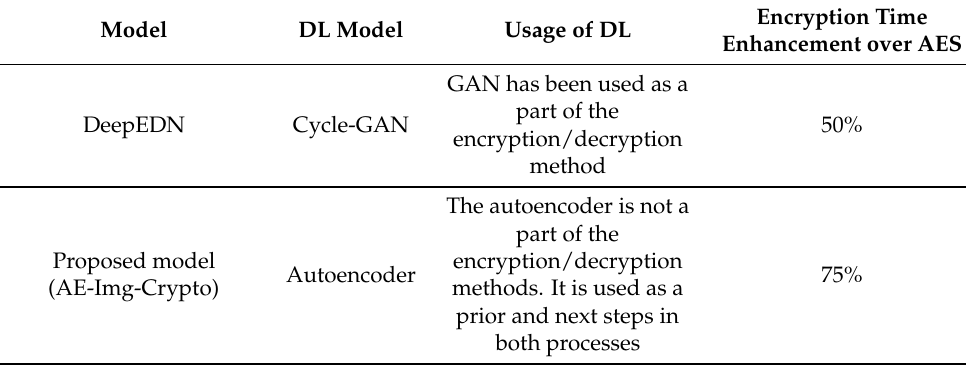
Table 4. Comparison with related